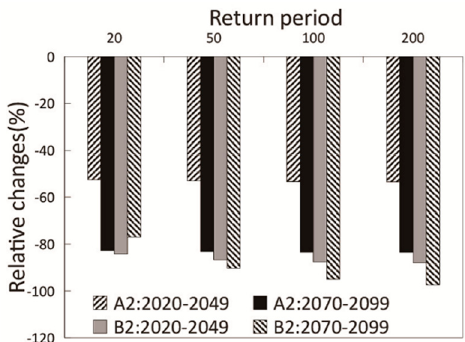
Figure 12. Changes in the encounter probabilities of floods with the same-frequency in comparison with the reference period.